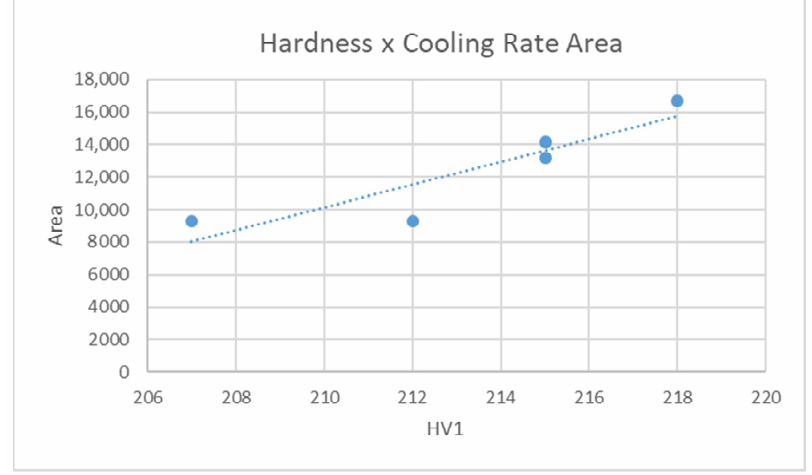
Figure 7. Hardness vs. amount of heat removed.